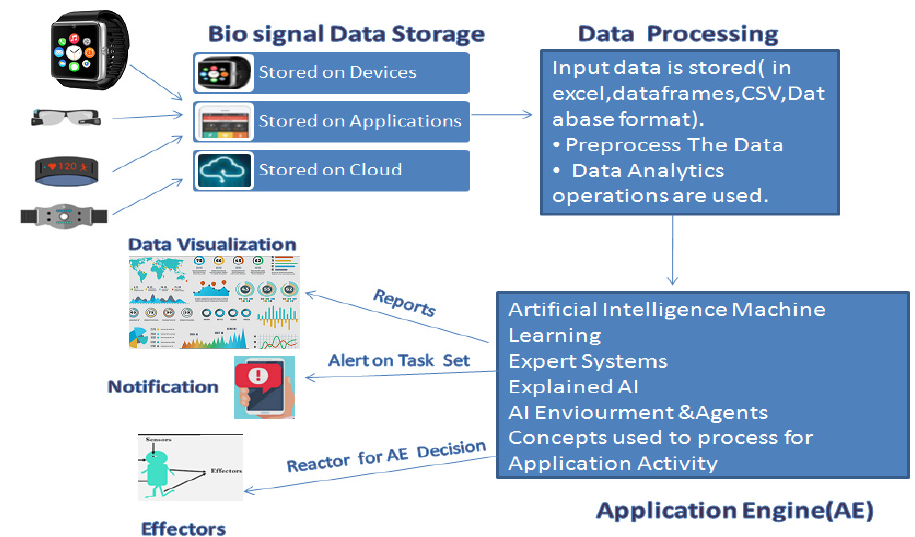
Figure 2. Architecture diagrams of bio ‐ signals processing environment .